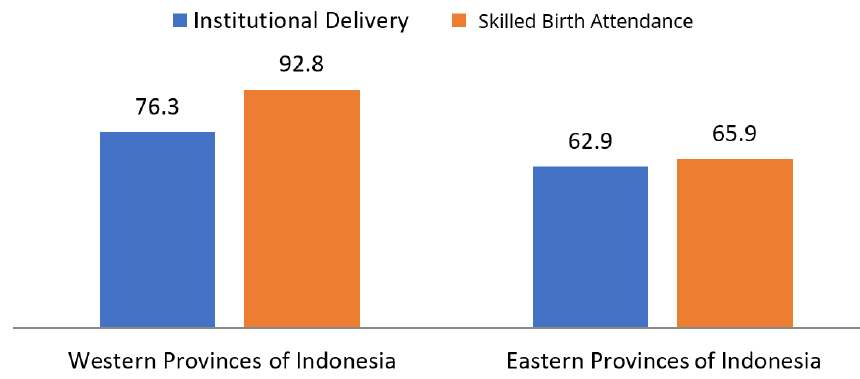
Figure 1. Institutional delivery and skilled birth attendants by western and eastern provinces of